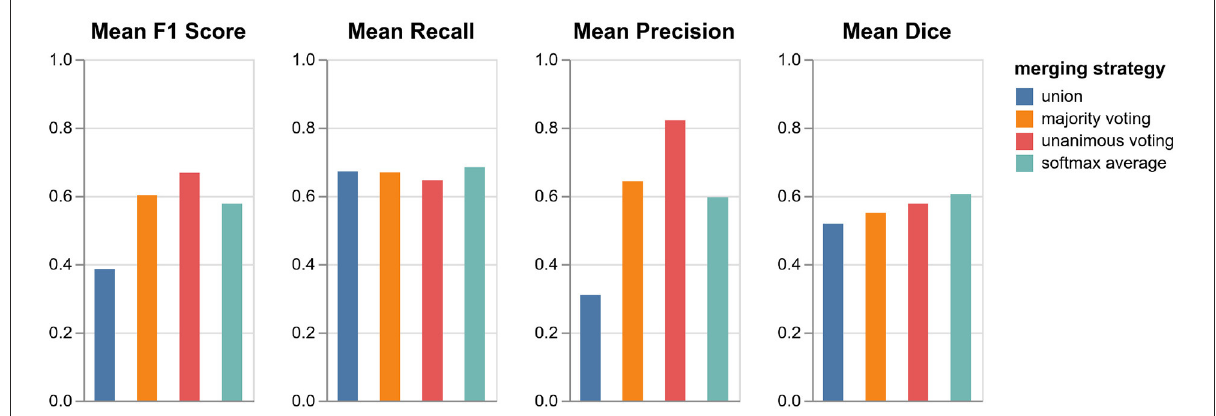
FIGURE4 Performance of pipeline mediaire-A with different strategies for merging the predictions from axial, coronal, and sagittal orientation. Scores are calculated on the 20 datasets in VAL-A-NL. The approaches union, majority voting, unanimous voting, and softmax averaging are compared in terms of F1 score, precision, recall, and Dice.